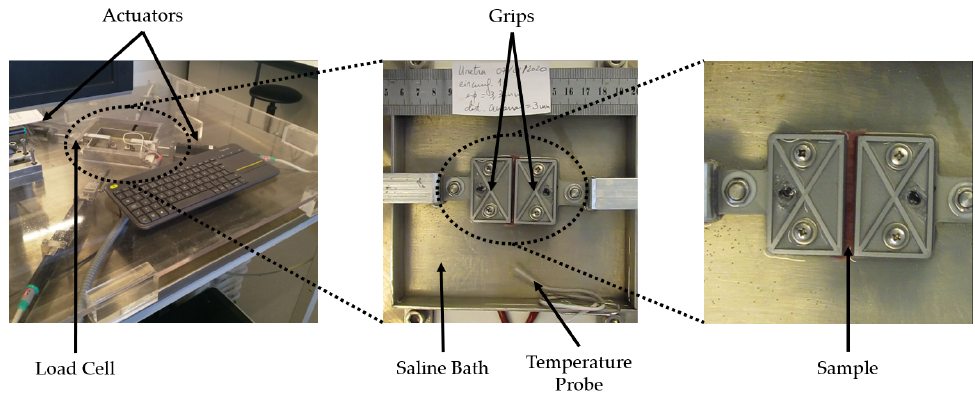
Figure 2. Experimental apparatus used to perform the mechanical